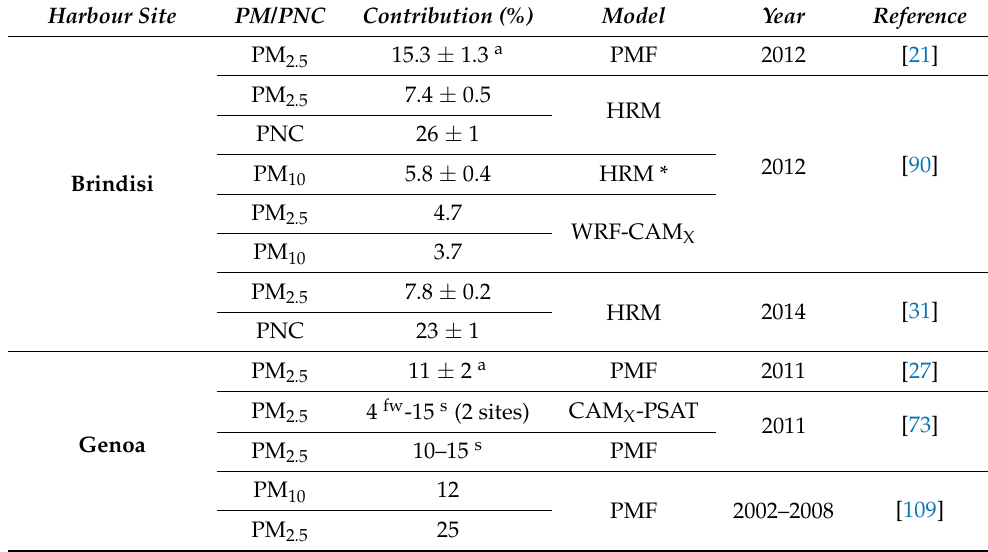
Table 2. Shipping primary contributions to PM and PNC, estimated by different